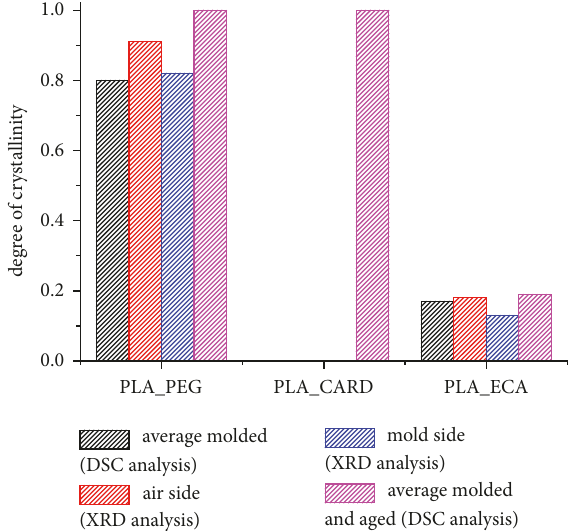
Figure 5: Degree of crystallinity for molded and aged samples estimated from DSC and XRD analysis.